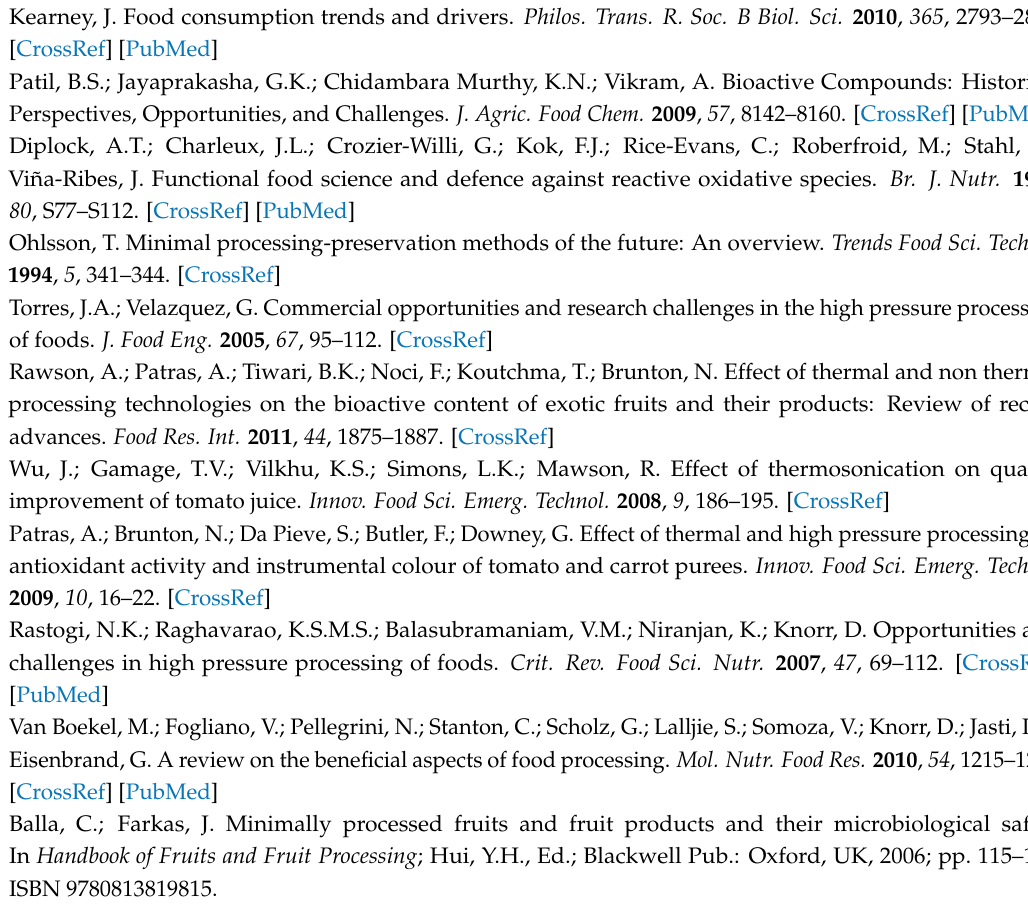
Supplementary Materials: The following are available online, Table S1: TPC (mg gallic acid equivalents/100 mL) of fresh, TP, and HPP orange juices and respective statistical data, Table S2: Total flavonoid content (mg rutin equivalents/100 mL) of fresh, TP, and HPP orange juices and respective statistical data, Table S3: Total anthocyanin content (mg cyanidin-3-glucoside equivalents/100 mL) of fresh, TP, and HPP orange juices and respective statistical data, Table S4. Total carotenoid content (mg β -carotene equivalents/100 mL) of fresh, TP, and HPP orange juices and respective statistical data, Table S5. Individual compounds content (mg/L) found in fresh and in thermal pasteurized (TP) and high-pressure processed (HPP) orange juices during storage, Table S6. Antioxidant activity expressed as antiradicalar power (ARP) (mL/mg) of fresh, thermal pasteurized (TP) and high-pressure processed (HPP) orange juices and respective statistical data, Table S7. Calibration data used for the HPLC-UV quantification of major components of fresh, thermal pasteurized (TP) and high-pressure processed (HPP) orange juices, Figure S1. HPLC-UV chromatogram of HPP orange juice at day of the treatment, recorded at 280 nm (1-Apigenin-6,8-di- C -glucoside, 2-Naringenin-7- O -rutinoside, 3-Hesperetin-7- O